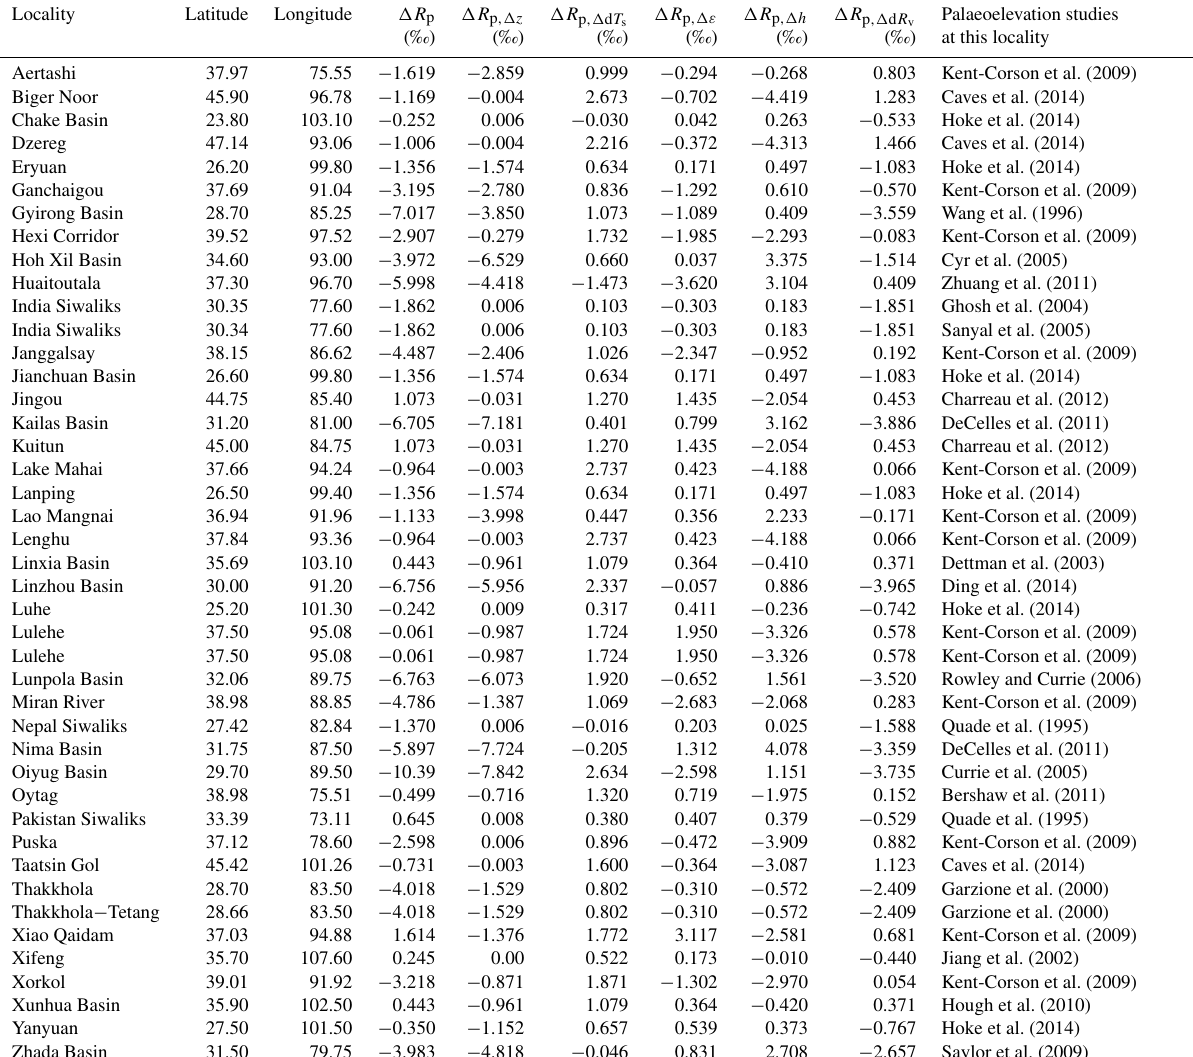
Table 4. Impact of the different terms of the decomposition on the isotopic signal for the terminal stage of HTP uplift in the location where palaeoelevation studies have been done.